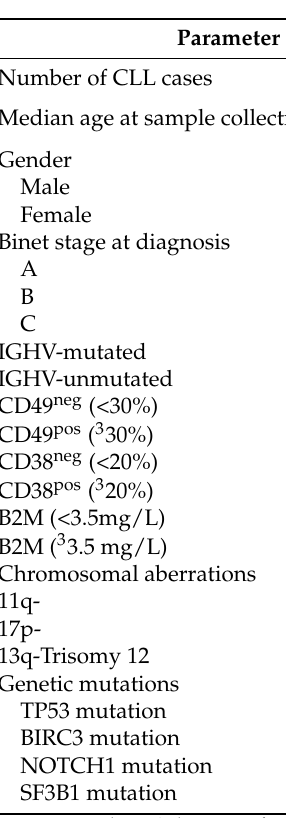
Table 1. Summary of CLL patient